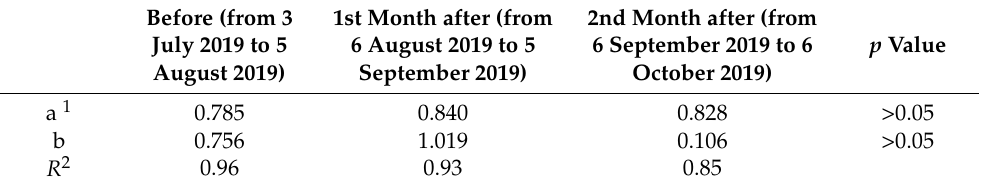
Figure 3. Comparison of the relationship between daily mean sap flow density (SFD) in the control and the N ‐ fertilized plots ( n = 3–15) in three periods: ( a ) before fertilization from 3 July 2019 to 5 August 2019, ( b ) 1st month after fertilization from 6 August 2019 to 5 September 2019, and ( c ) 2nd month after fertilization from 6 September 2019 to 6 October 2019. Formulas correspond to each regression line. R 2 is the coefficient of determination. Error bars are the standard deviation of SFDs in individual trees ( n = 3–15) for each plot. Table 3. Comparison of slopes and interceptions of regression lines in Figure 3. Before (from